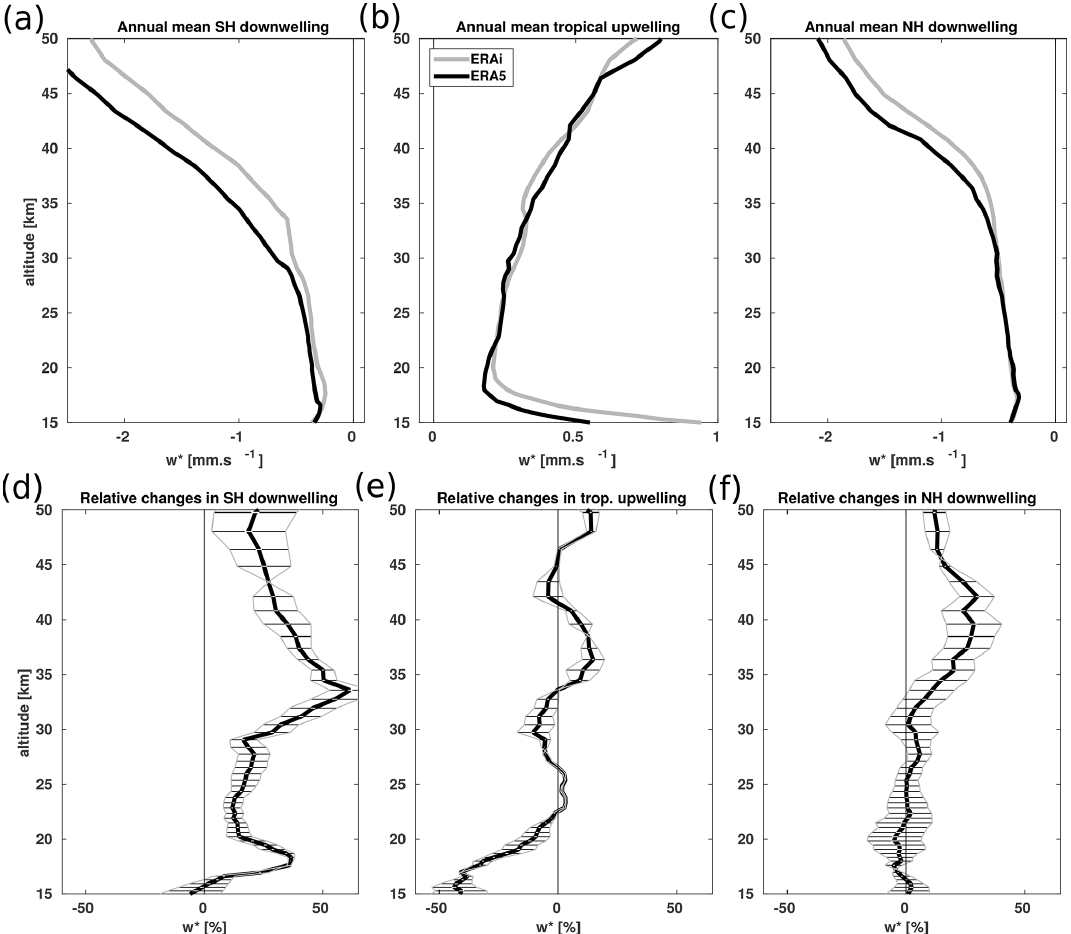
Figure 2. Vertical profiles of the turnaround annual mean w ∗ (in mms − 1 ): (a) SH downwelling, (b) tropical upwelling, and (c) NH down- welling from the ERA5 reanalysis (black) and the ERA-Interim reanalysis (light grey) for the 1979–2018 time period. Panels (d–f) show the ERA5 minus ERA-Interim w ∗ , expressed as a percent difference relative to monthly mean. The error bars represent the 2 σ significance level. Differences between the ERA5 and ERA-Interim reanalyses are significant where deviations from zero exceed the 2 σ